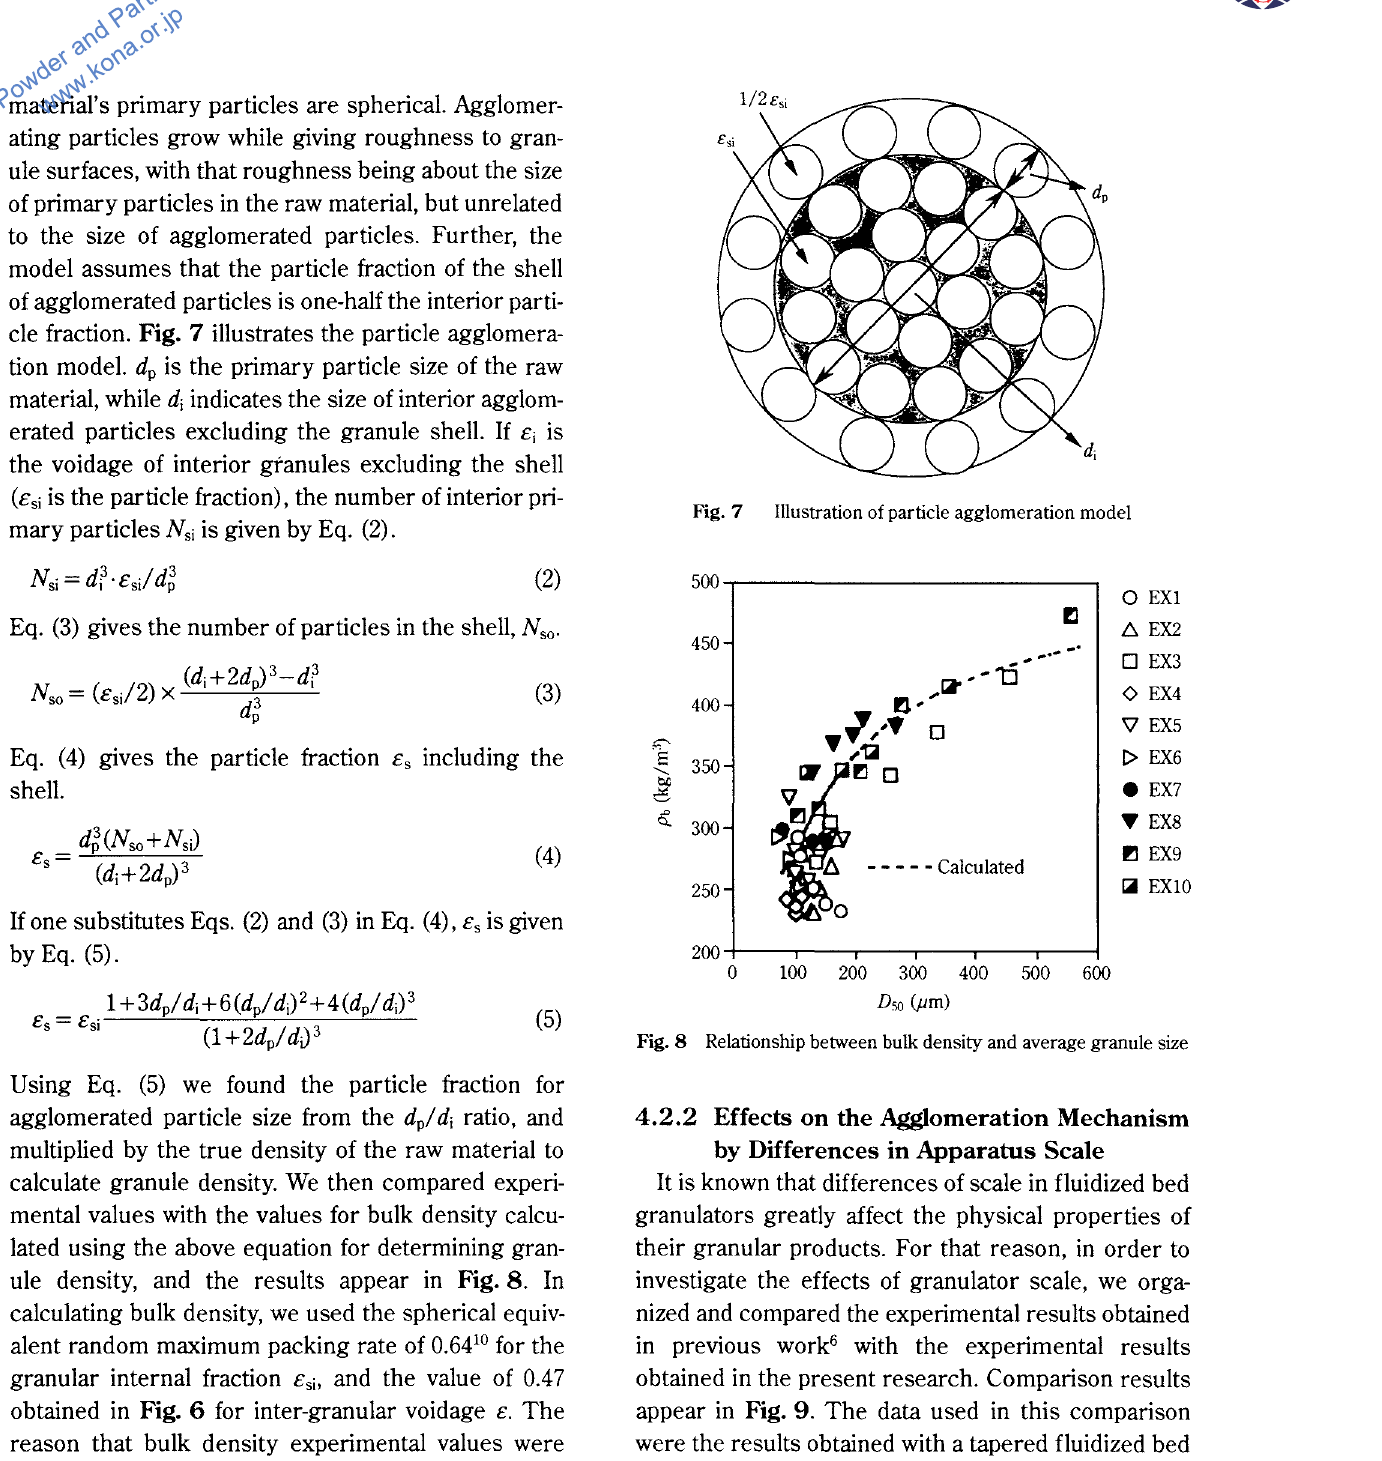
Fig. 7 Illustration of particle agglomeration model